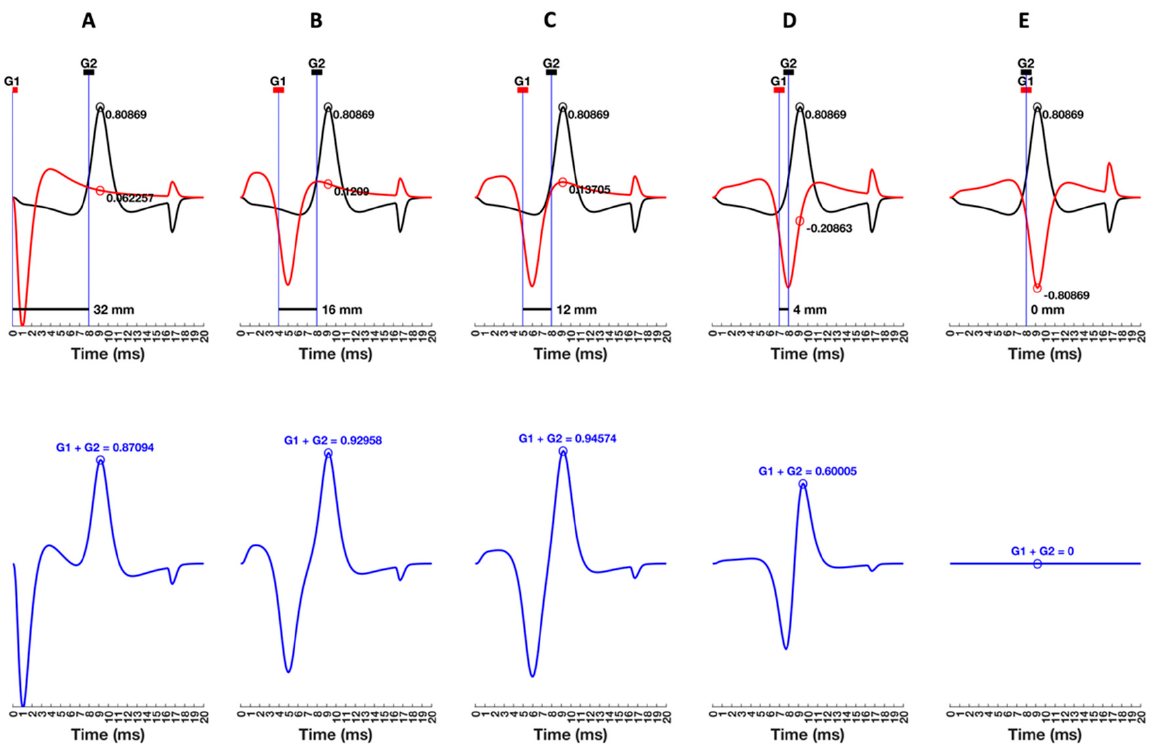
Figure 7. The monopolar recordings of a motor unit action potential (MUAP) by two different electrodes, G1 and G2. The location of G2 remains between the innervation zone (IZ) and the muscle–tendon junction, while G1 is moved closer to G2 to decrease the distance between them (top panels ( A – E )). The bottom panels show the difference between the two monopolar MUAP recordings to construct a bipolar MUAP, as would occur with differential amplification, for each distance between G1 and G2. The sign conventions are G1 (+) and G2 ( − ), which means that the input to G1 is unaltered and the input to G2 is inverted by the op-amp and now displayed so the depolarization phase is positive above the horizontal zero line. The x -axis is the time-evolution of the MUAP in milliseconds for CV = 4